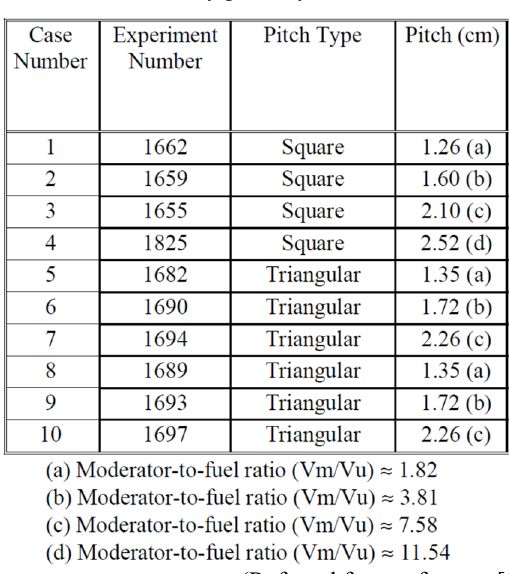
Table 3. Array geometry of LCT-007.